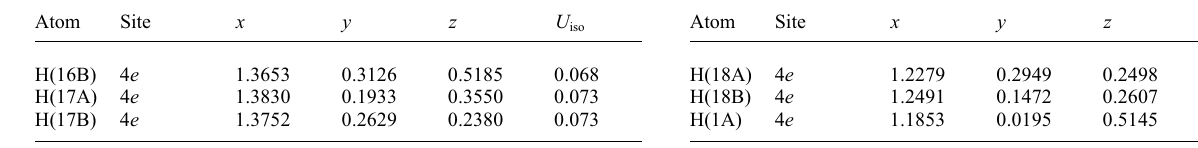
Table 3. Atomic coordinates and displacement parameters (in Å 2 )